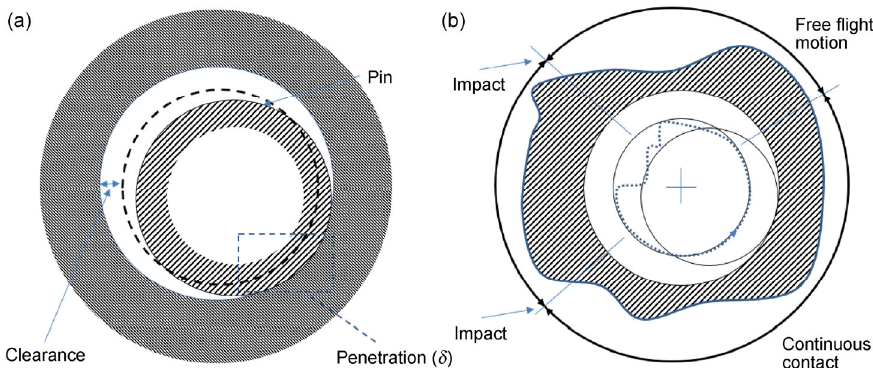
Fig. 11 The different modes in a revolute joint with clearance [109], and penetration in joints